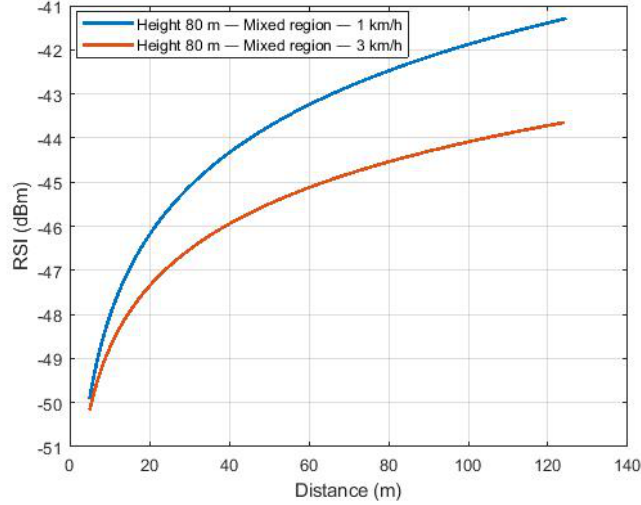
Figure 8. Path loss of flights over the mixed